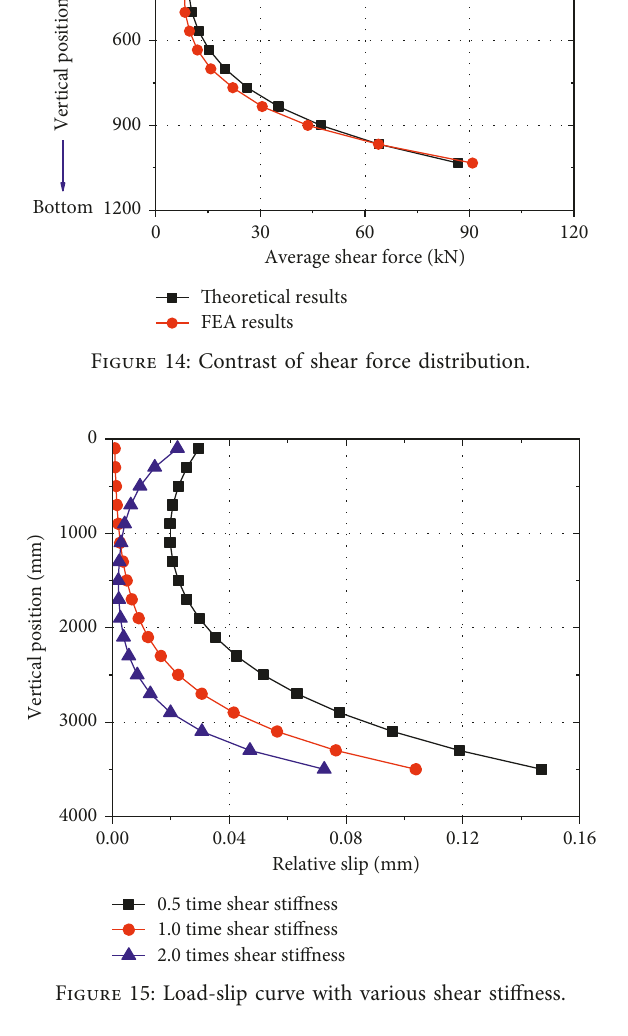
Figure 17: The relationship between the shear force and the axial stiffness of the hybrid